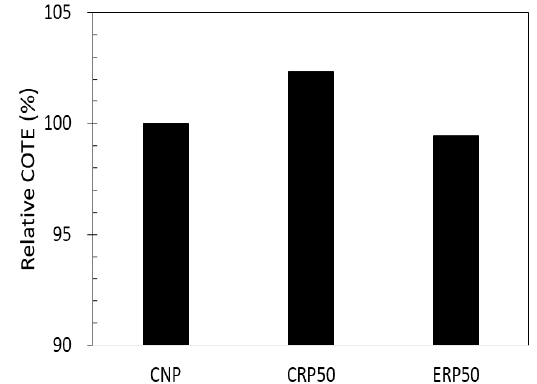
Figure 8. Average relative COTE values from mix series 2 and 3.